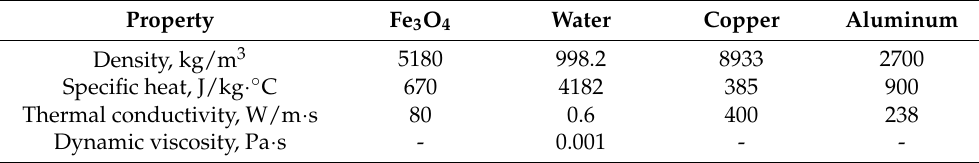
Figure 2. Detailed view of cooling channel with internal fins. Table 1. Thermophysical properties of ferrofluid nanoparticles and